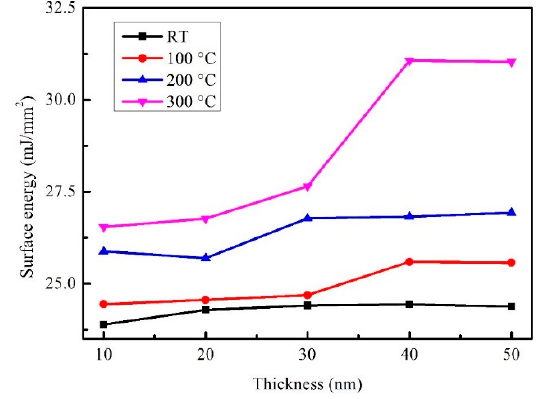
Figure 8. Surface energy of CoFeBY nanofilms.